Question: What type of chart is this?
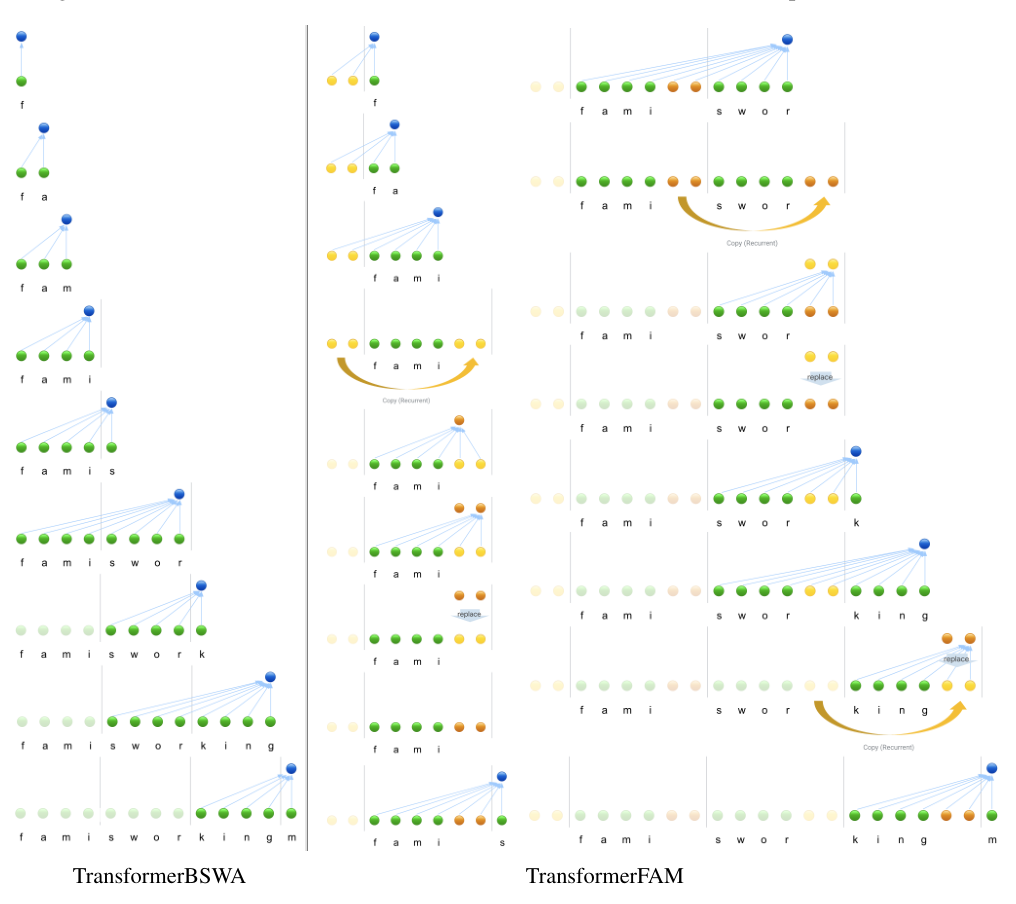
Answer: line